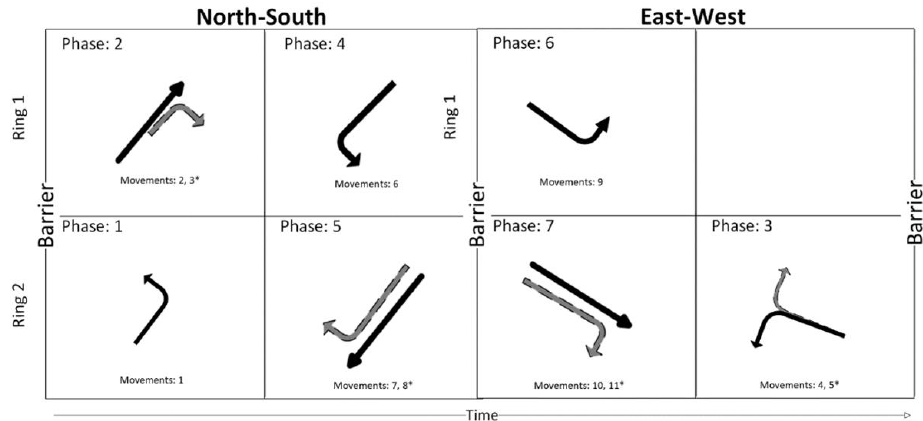
Figure 2. Full Ring and Barrier diagram for Cleveland Avenue and Seventeenth Street.